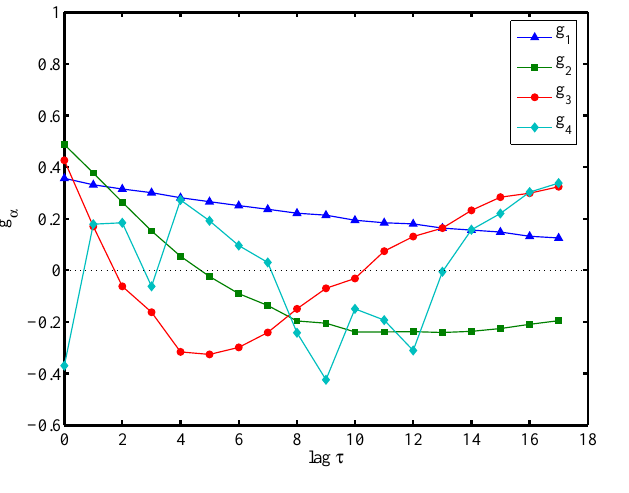
Fig. 3. The first four modes g α (τ) , with α =[ 1 , 2 , 3 , 4 ] . Only the first three modes have a regular decaying shape. Thus, these modes are used to reconstruct all ACFs.